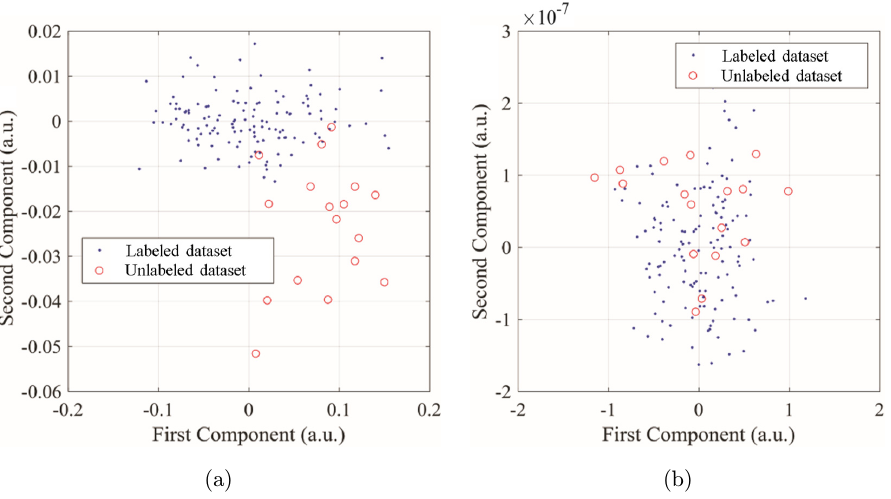
Fig. 7. Comparison of data distributions in typical series: (a) L 1 input layer and (b) L 3 output layer.